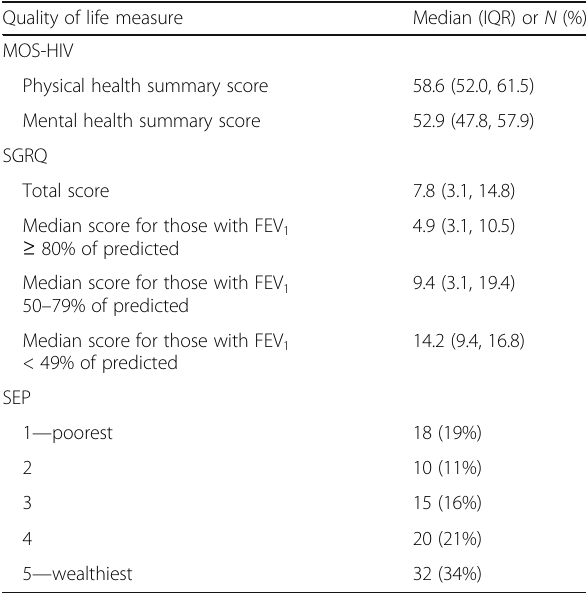
MOS-HIV Medical Outcomes Survey HIV, SGRQ St. George ’ s Respiratory Questionnaire, SEP socioeconomic